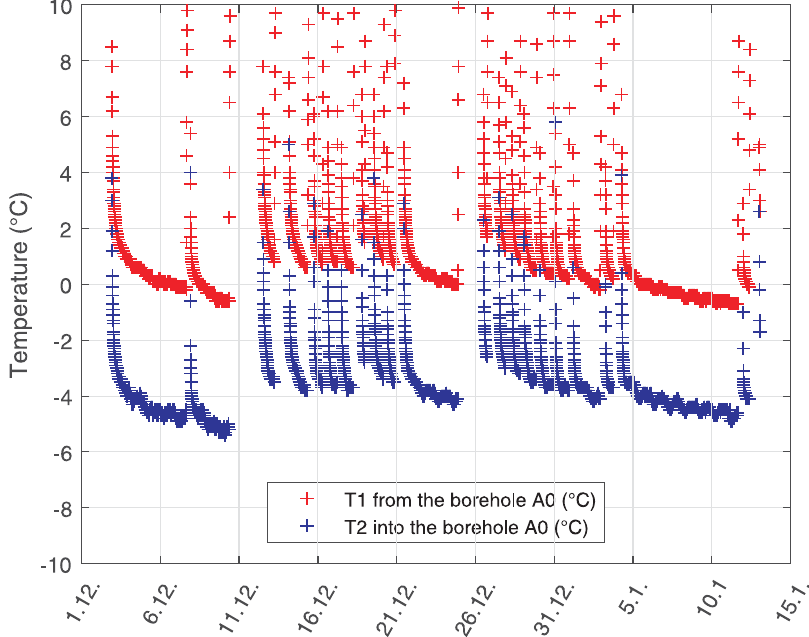
Figure 4. Time detail of the temperature change course in the A0 borehole with the lowest tempera-